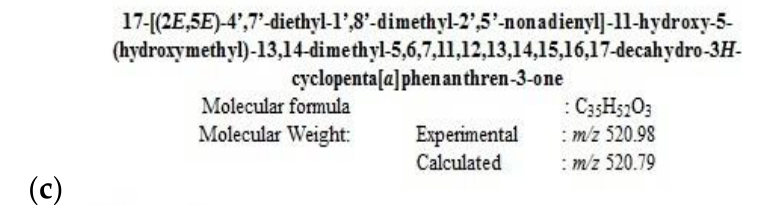
Figure 1. Structures of the novel compounds ( a ) 2879/CHE/2012(cpd-1); ( b ) 2880/CHE/2012(cpd-2); ( c ) 2881/CHE/2012(cpd- 3).